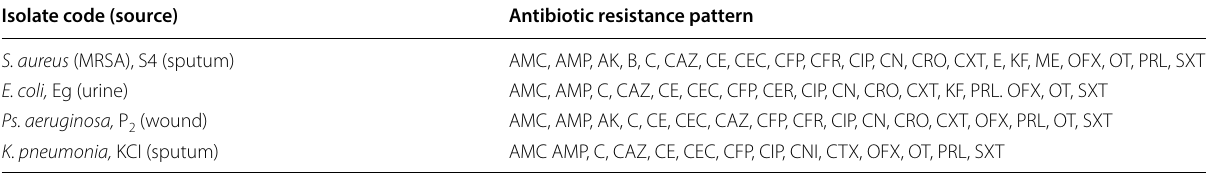
MRSA: methicillin-resistant Staphylococcus aureus , AK; amikacin AMC: amoxicillin/clavulanate; AMP: ampicillin; B: bacitracin; C: chloramphenicol; CAZ: ceftazidime; CE: cephradine; CEC: cefaclor; CFP: cefoperazone; CFR: cefadroxil; CIP: ciprofloxacin; CN: gentamicin; CRO: ceftriaxone; CTX: cefotaxime; E: erythromycin; KF: